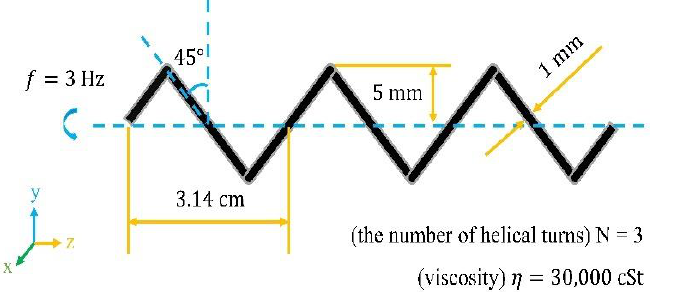
Figure 2. The related dimensional Basic model ( θ = 45 ◦ , A = 5 mm, d = 0.5 mm, λ = 3.14 cm, f = 3 Hz, N = 3, and η = 30,000 cSt).